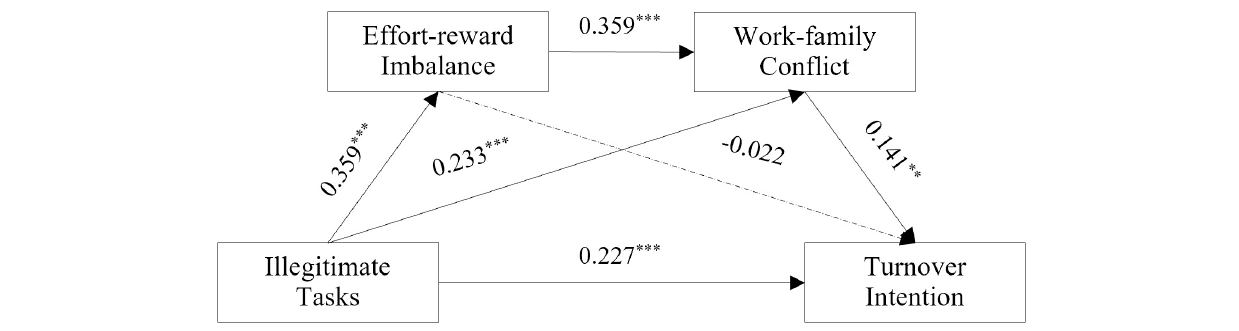
FIGURE 2 | Roadmap of the influence of illegitimate tasks on turnover intention. * p < 0.05, ** p < 0.01, *** p <